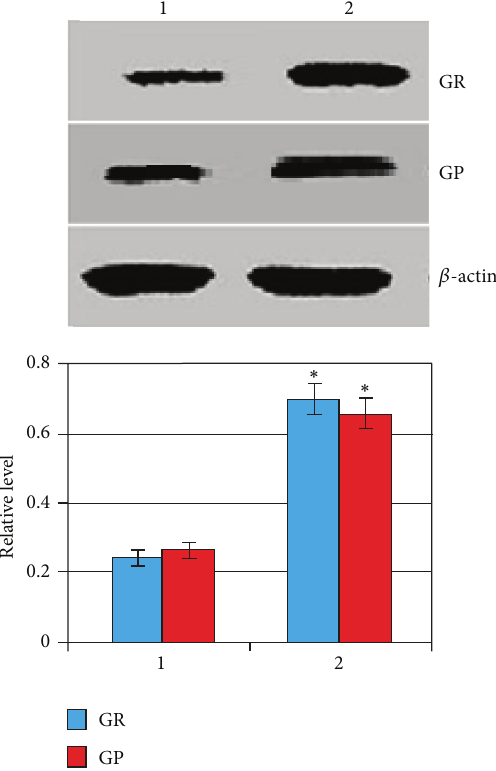
Figure 5: The Western blotting analysis of protein level for GR and GP, or actin in liver isolated from control group of rats (1) and CCl 4 - induced animals at 96h after exposure (2). Compared with control: ∗ 𝑃 < 0.05